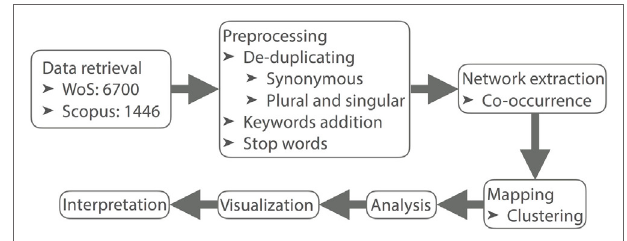
FigUre 1 | Workflow of the analysis